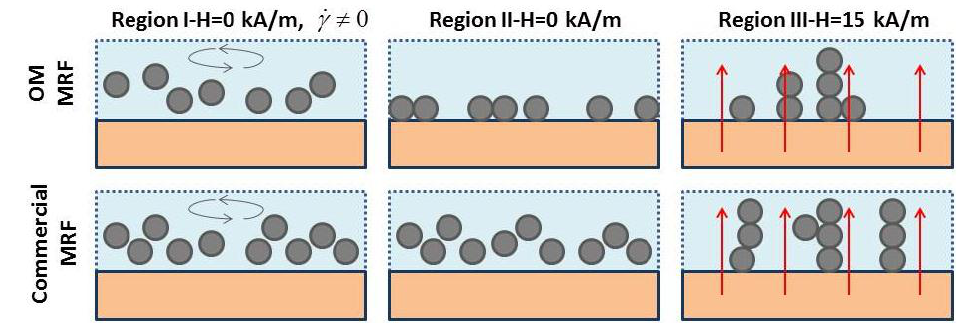
Figure 5. Scheme of possible structures formed in OM MRF and commercial MRF at the pre-shear stage-region I ( Left ), at rest -region II ( Middle ), and under the effect of a magnetic field-region III ( Right ).